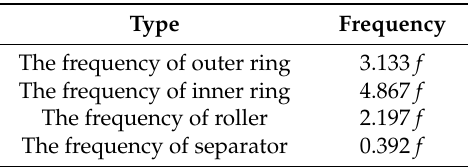
Table 3. The fault frequency of FAG6326C3.